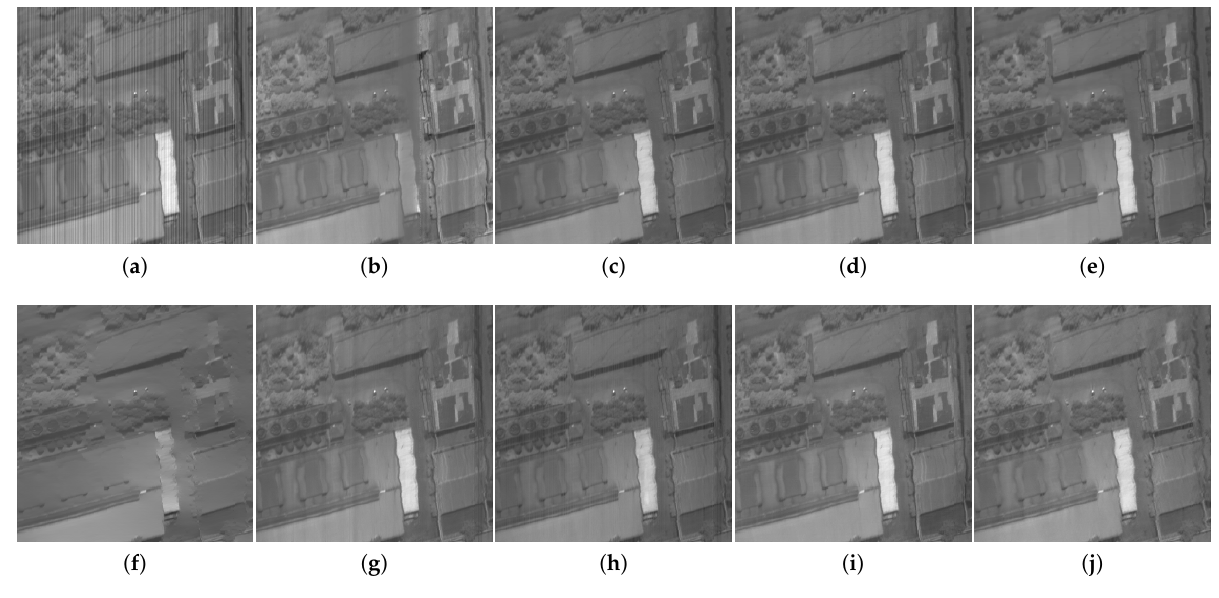
Figure 9. Corrected SWIR images for band 264. ( a ) SWIR image. Images corrected by ( b ) MM, ( c ) AS-